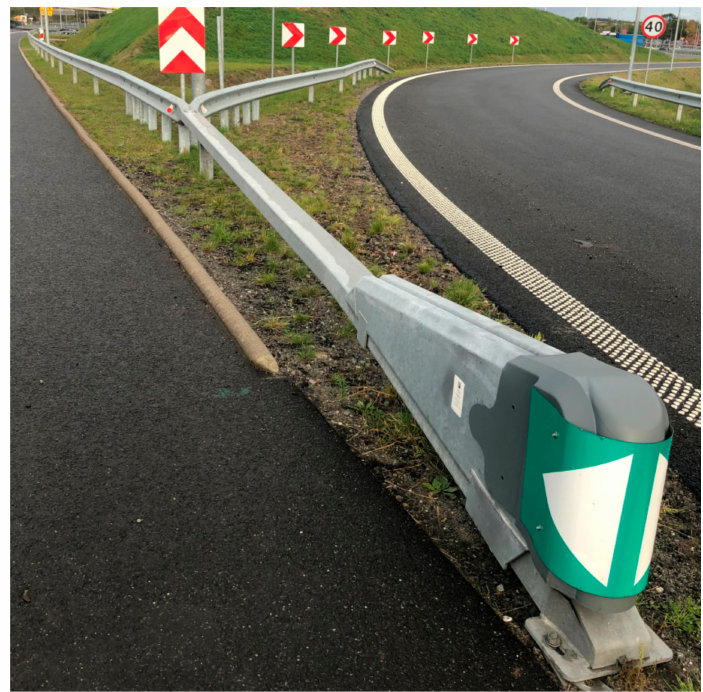
Figure 3. Example of SE